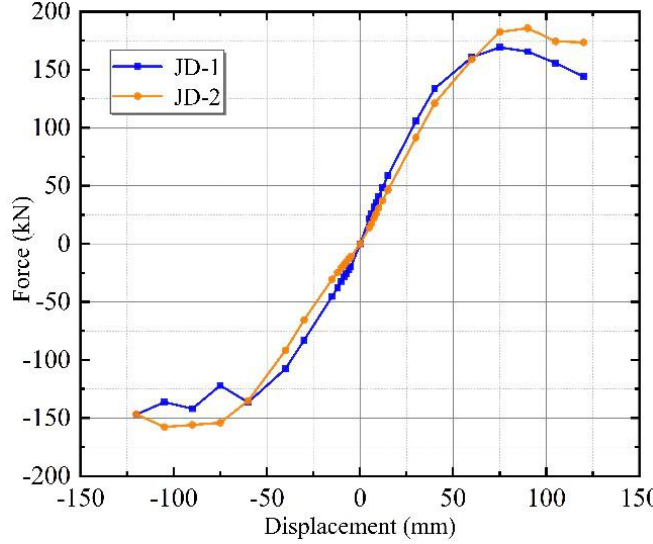
Figure 9. Skeleton curves of JD-1 and JD-2. Table 3. Characteristic values on skeleton curves of specimens.